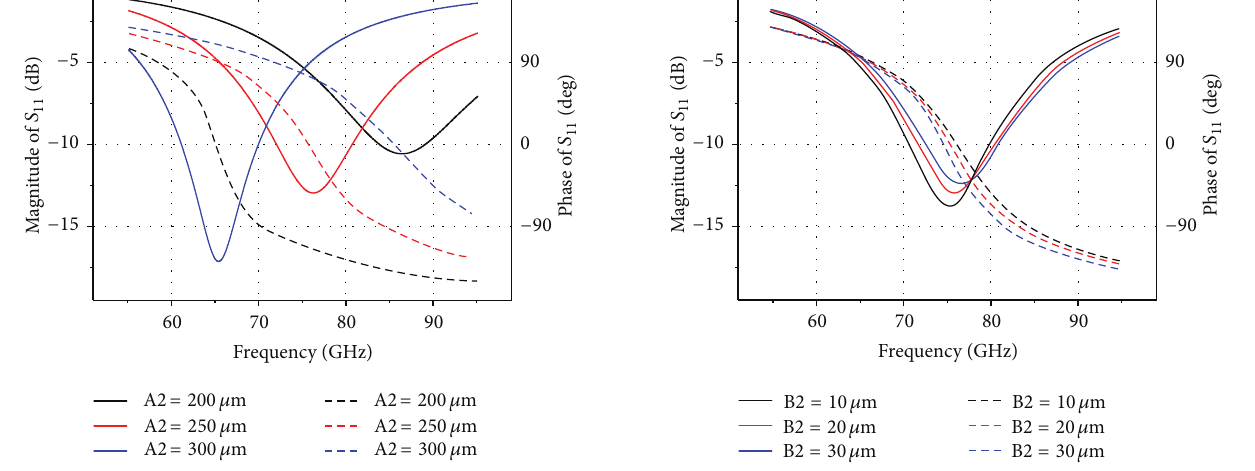
Figure 6: Magnitude and phase of reflection coefficient versus geometrical parameter A2.